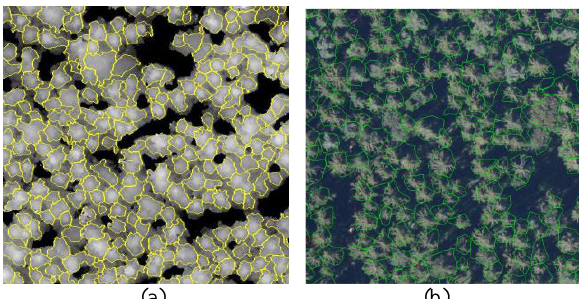
Figure 9. The extracted tree crown boundaries overlaid on the DSM (a) and original image